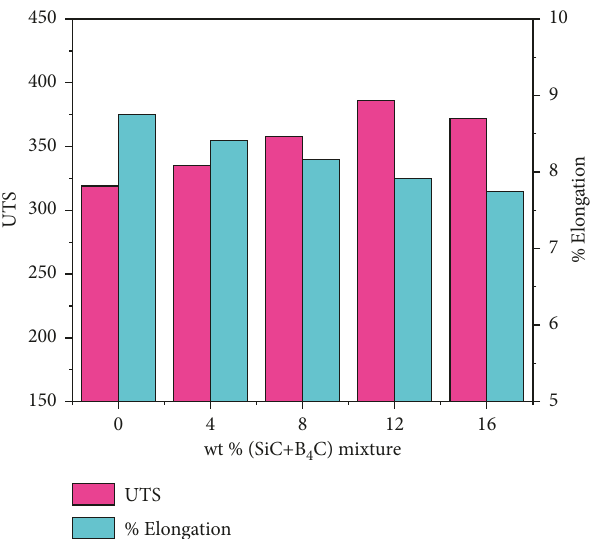
Figure 9: Ultimate tensile strength and % elongation for different weight percentages of (SiC +B 4 C) mixture.